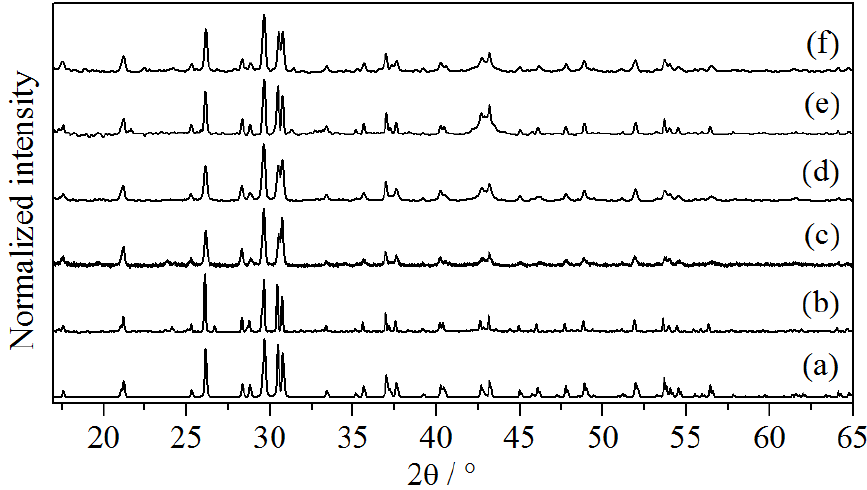
Figure 1. ( a ) Calculated X-ray diffraction (XRD) pattern for Ba measurements for ( b ) synthesized bulk Ba combustion; ( d ) Ba SiO :Eu 2+ NPs after annealing; ( e ) undoped Ba 2 4 ( f ) Ba SiO :Sr 2+ 2 4